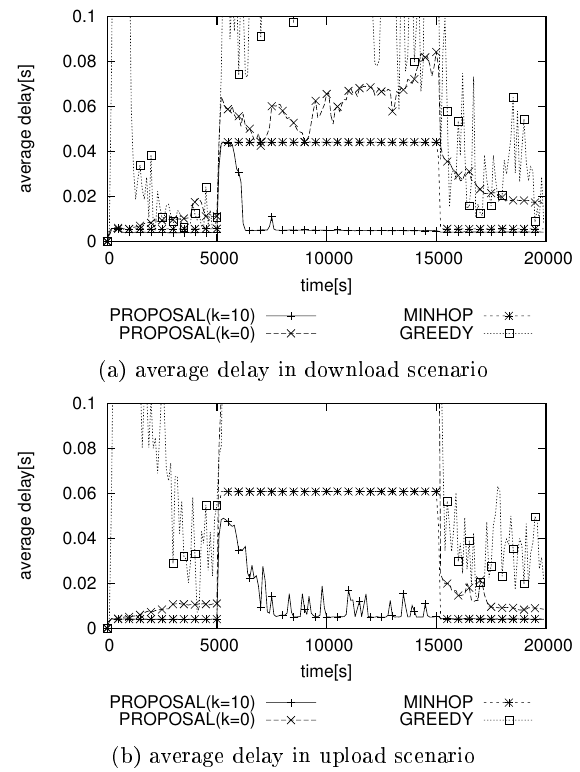
Figure 2: time courses of average delay